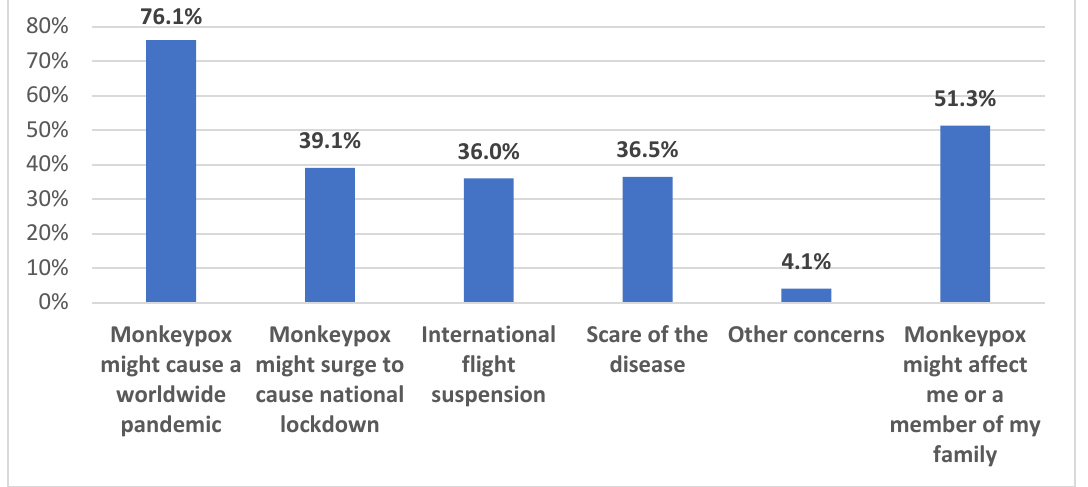
Figure 4. Participants’ sources of worry of Mpox disease.